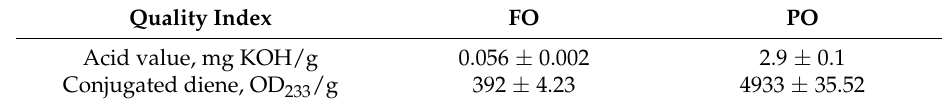
Table 1. Quality index of fresh soybean oil (FO) and polar compounds (PO) from oxidized frying oil. Quality Index